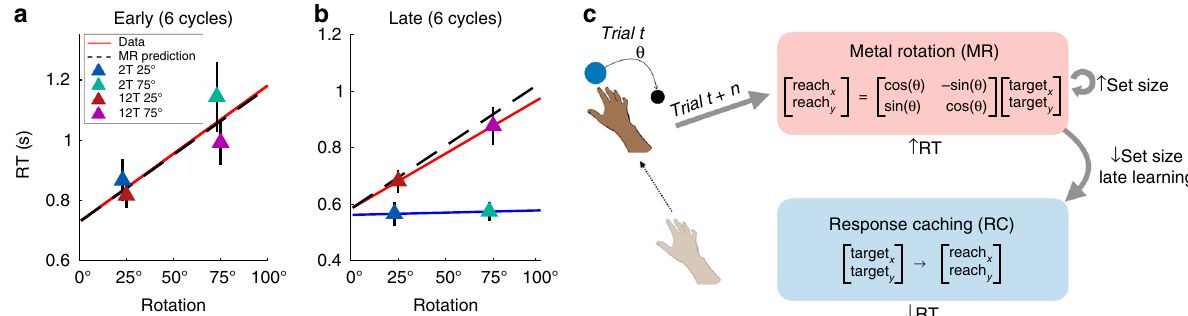
Fig. 8 Mental rotation pace from FREE task matches RT data in Experiment 1. a Mean of median RTs in early learning from Experiment 1 (triangle markers; n = 80) with a regression line, for visualization, on all four groups ’ data (red), and the regression line predicted by the mental rotation pace gleaned from the FREE task ( n = 32) using the same intercept (dashed black). b Same as a on late learning data, with separate regression lines for the 12T groups (red) and 2T groups (blue). c Schematic describing a parametric to discrete learning shift, which is mediated by set size. Error bars represent 1 s.e.m.